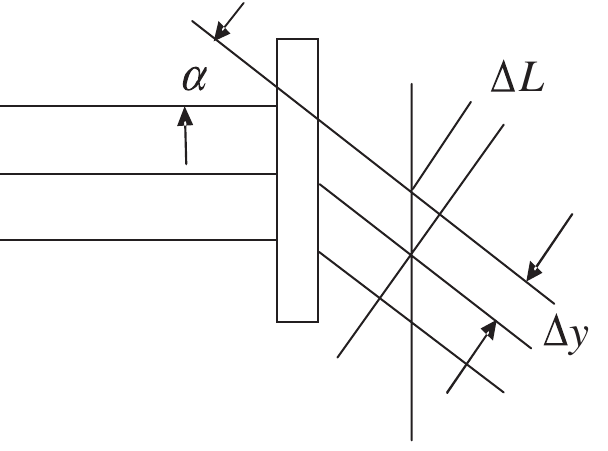
FIG. 7. Pulse lengthening at a transmission